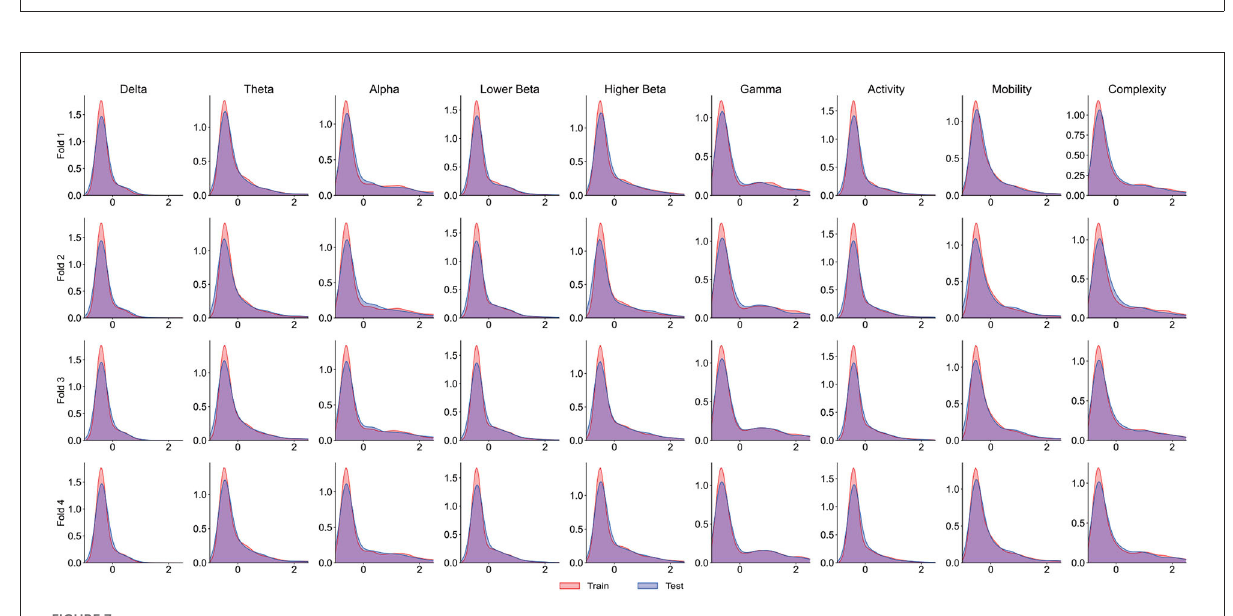
abnormal discharges at electrodes in the central zone (Blume,